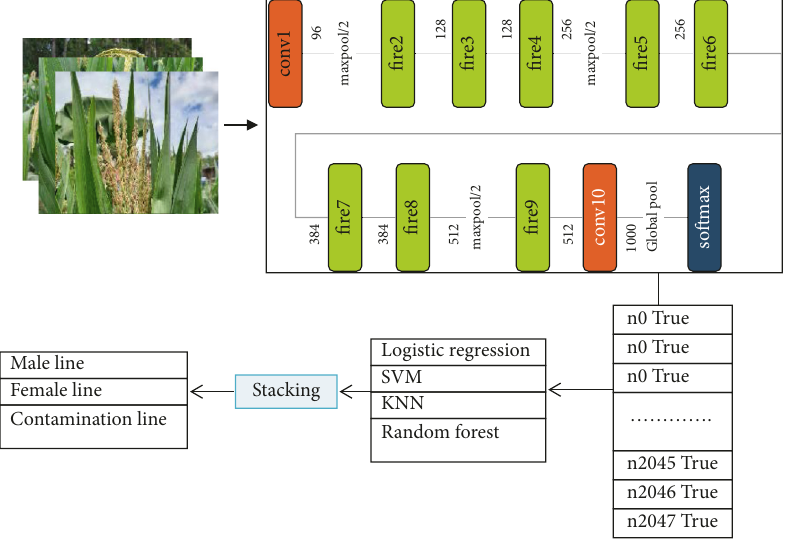
Figure 4: Proposed ensemble process using transfer learning based on the SqueezeeNet